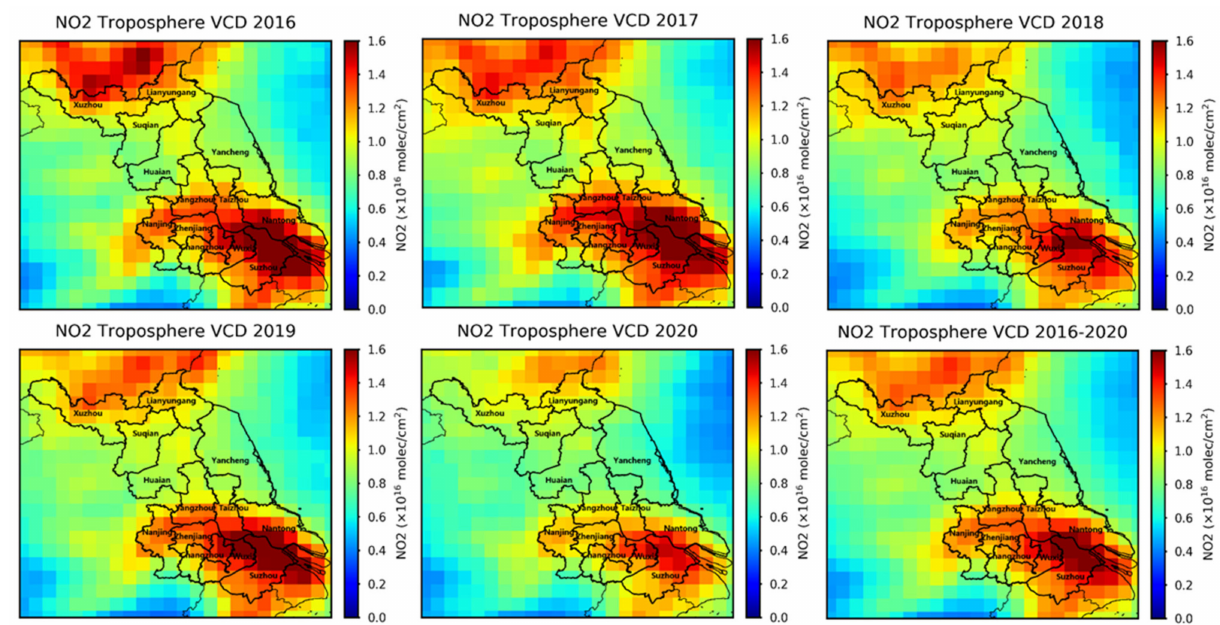
Figure 1. Averaged tropospheric NO 2 VCDs of Jiangsu province from 2016 to